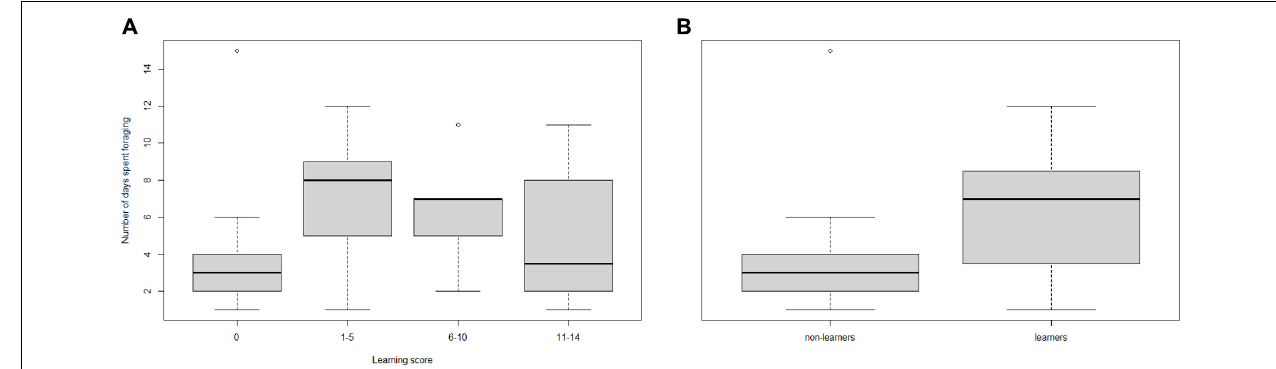
FIGURE 3 | Box and whisker plot showing (A) the number of days spent foraging against olfactory learning performance index score, and (B) the number of days spent foraging by non-learners vs. learners (raw data). High learning scores are indicative of fast learning individuals, whilst a score of zero means they showed no sign of learning. The number of bees in each learning category: 0 = 11, 1–5 = 13, 6–10 = 9, and 11–14 = 6. In each box the thick horizontal line indicates the median, whilst the lower and upper edges represent the 25 and 75% quartiles, respectively. Whiskers indicate minimum and maximum values that are not outliers. Outliers ( ± 1.5*IQR) are represented by open circles. (A) learning score 0: mean days foraging 3.91 ± 1.19 [SE]; learning score 1–5: 7.08 ± 0.98 [SE]; learning score 6–10: 6.22 ± 0.83 [SE]; learning score 11–15: 4.83 ± 1.62 [SE], (B) Non-learners mean days foraging: 3.91 ± 1.19 [SE], learners: 6.32 ± 0.63 [SE].